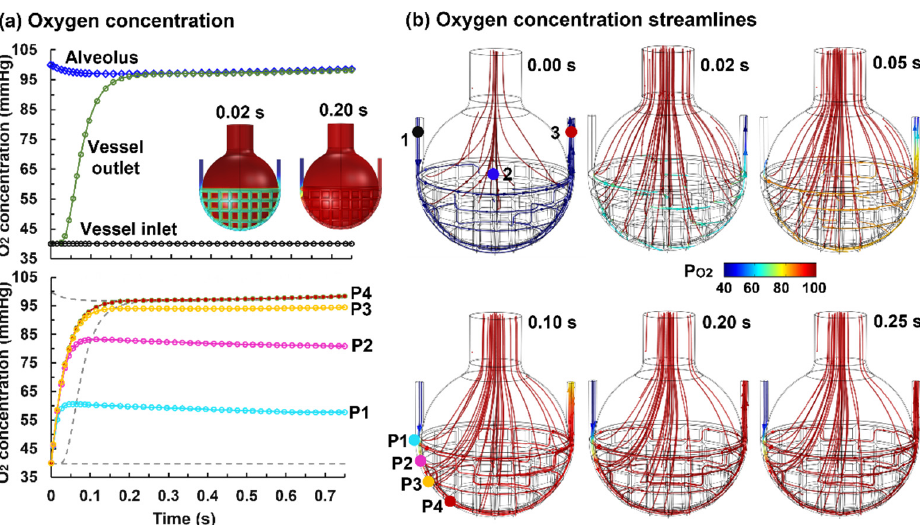
Figure 8. Oxygen exchange in the alveolus–capillary model: ( a ) temporal variation in oxygen partial pressure (PO 2 ) at various locations: the alveolar center, capillary vessel inlet, vessel outlet ( upper panel ), and four points (P1–P4) within the vessel network ( lower panel ); ( b ) streamlines for PO 2 (the instantaneous direction of PO 2 ) at varying instants.